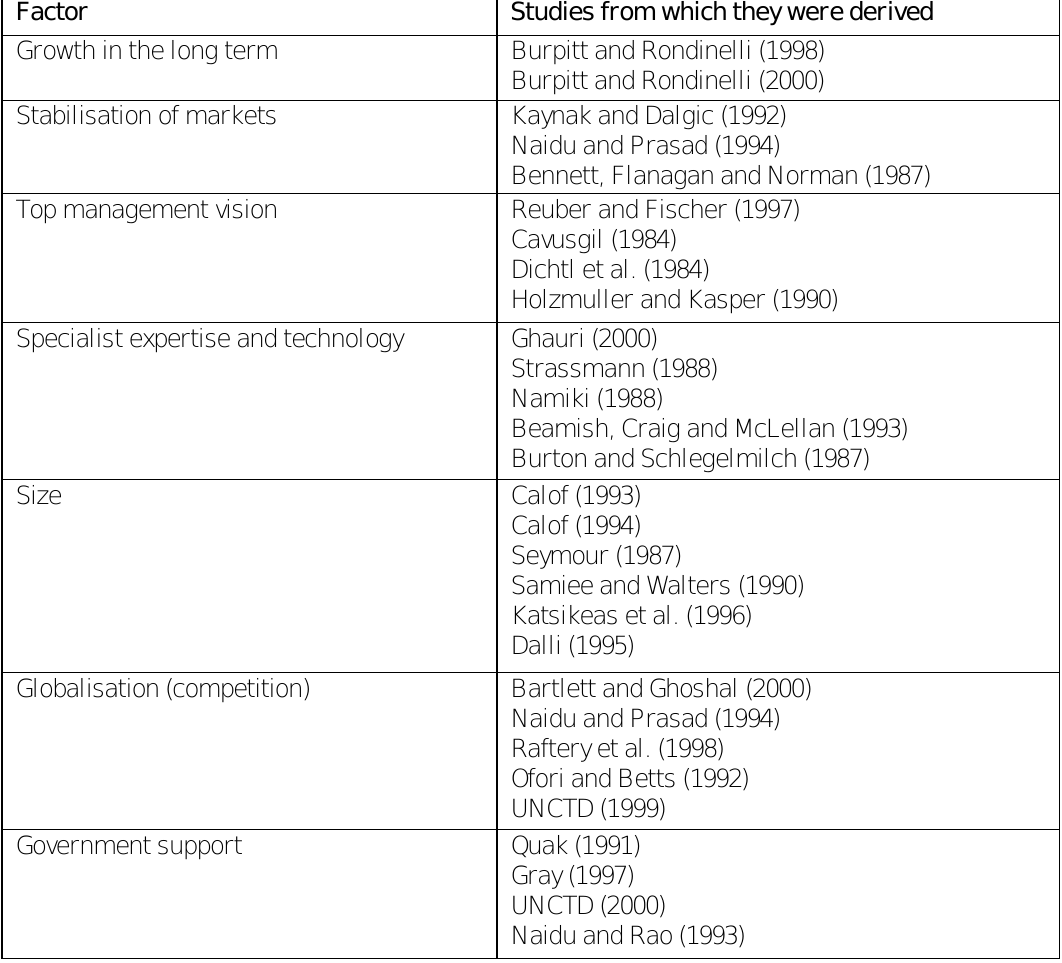
Table 2: Factors that motivate firms to internationalise